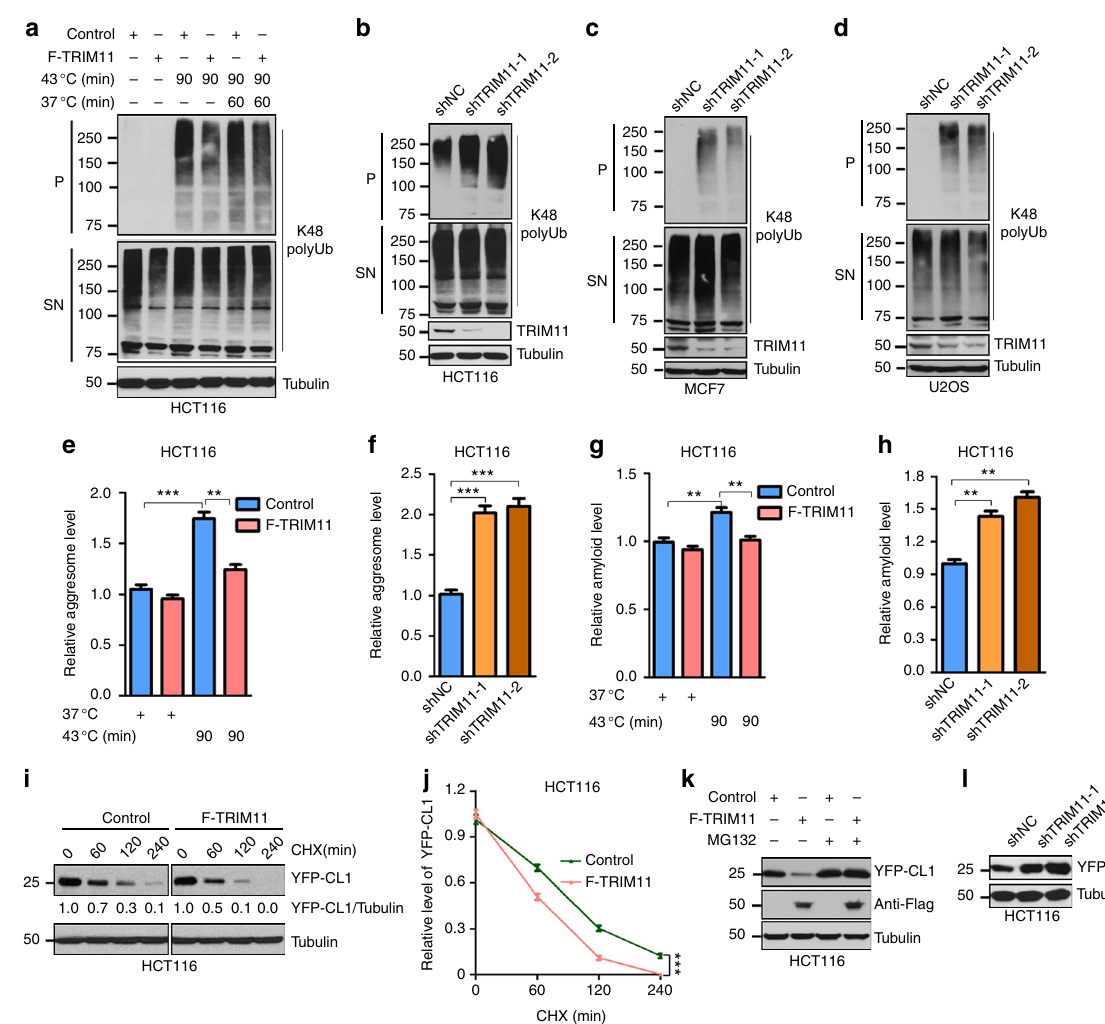
Fig. 1 TRIM11 promotes degradation of misfolded proteins. a HCT116 cells infected with control or Flag-TRIM11 (F-TRIM11) lentiviruses were grown at 37